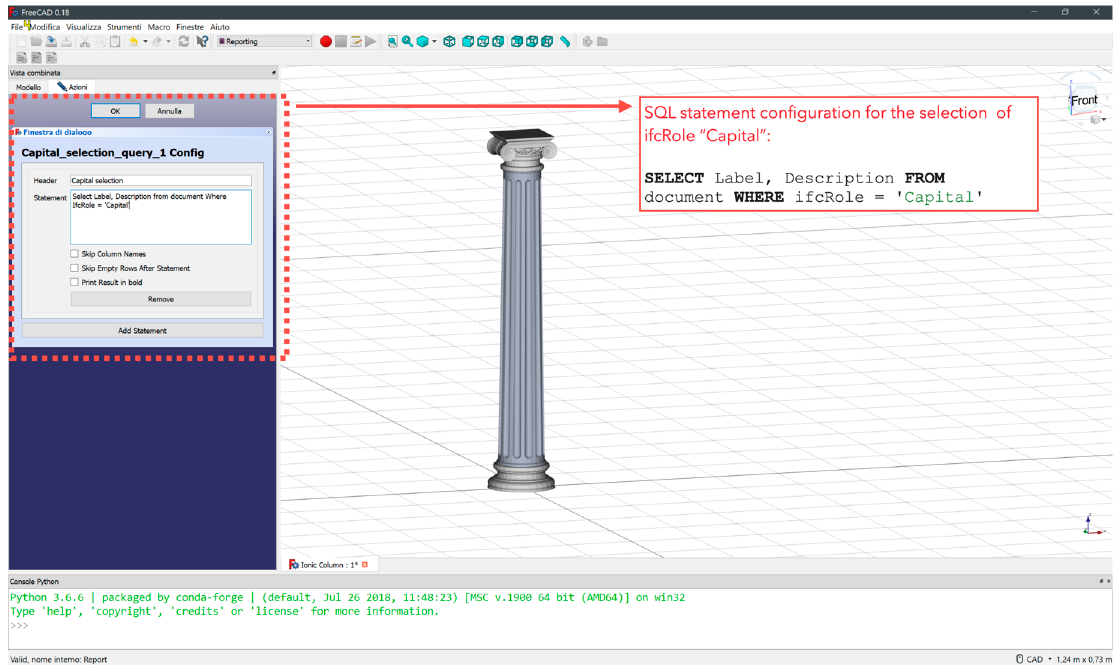
Figure 13. SQL query performed by using predefined statements and datasheet report in order to investigate Capital IFC custom role and its description: on the left side of FreeCAD is the SQL statement preparation for custom query. Appl. Sci. 2020 , 10 , x FOR PEER REVIEW 14 of 23